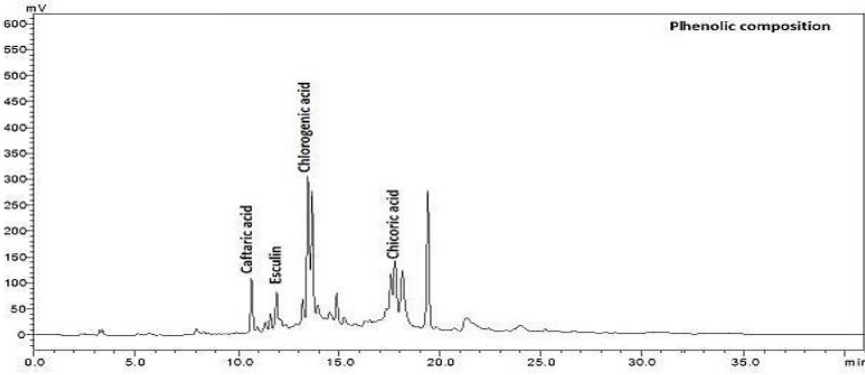
Figure 2. The chromatogram of phenolic composition of Cichorium intybus L .